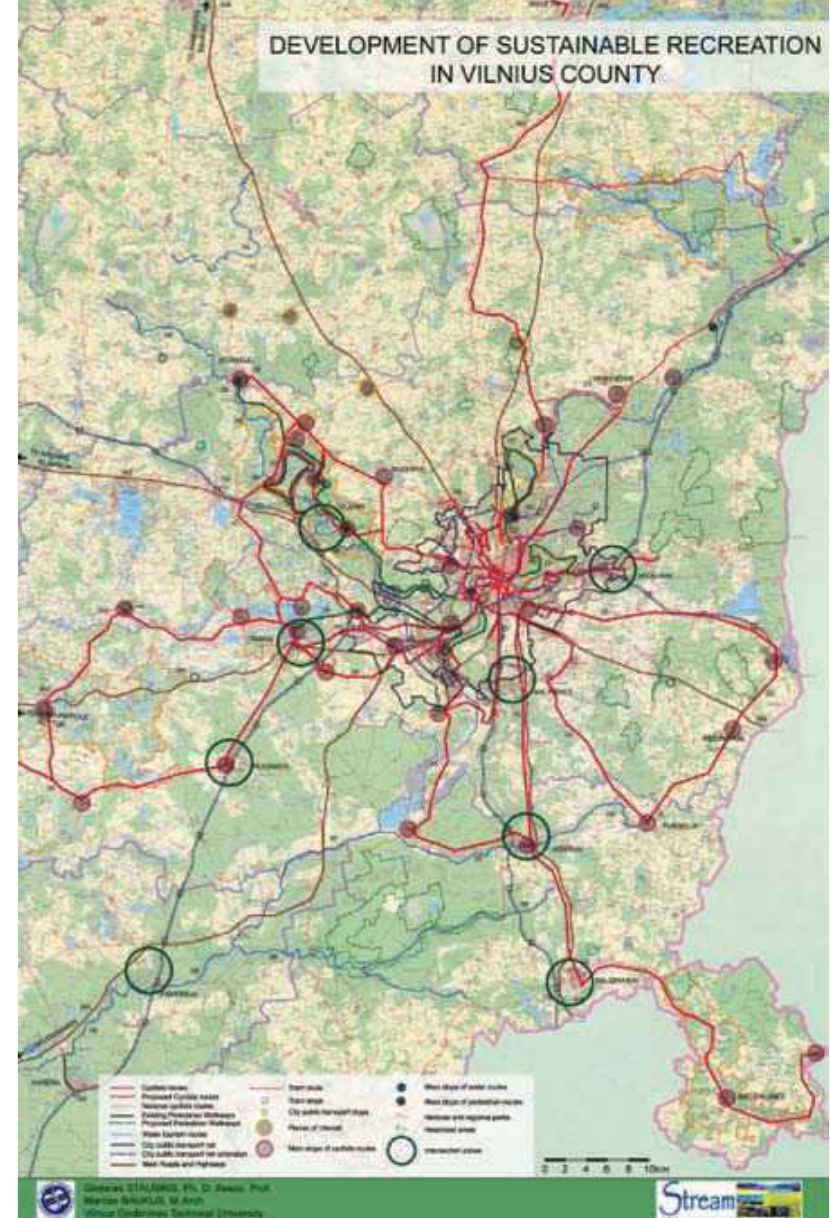
Fig. 5. Planning proposals for the network of sustainable recreation and tourism tracks in Vilnius